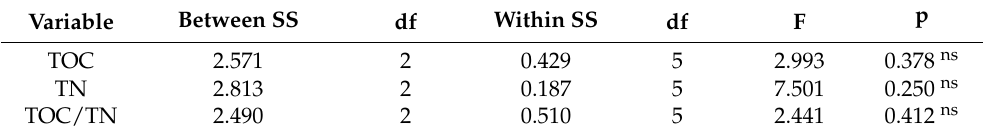
Table 7. Analysis of variance (k-means method) for TOC, TN and